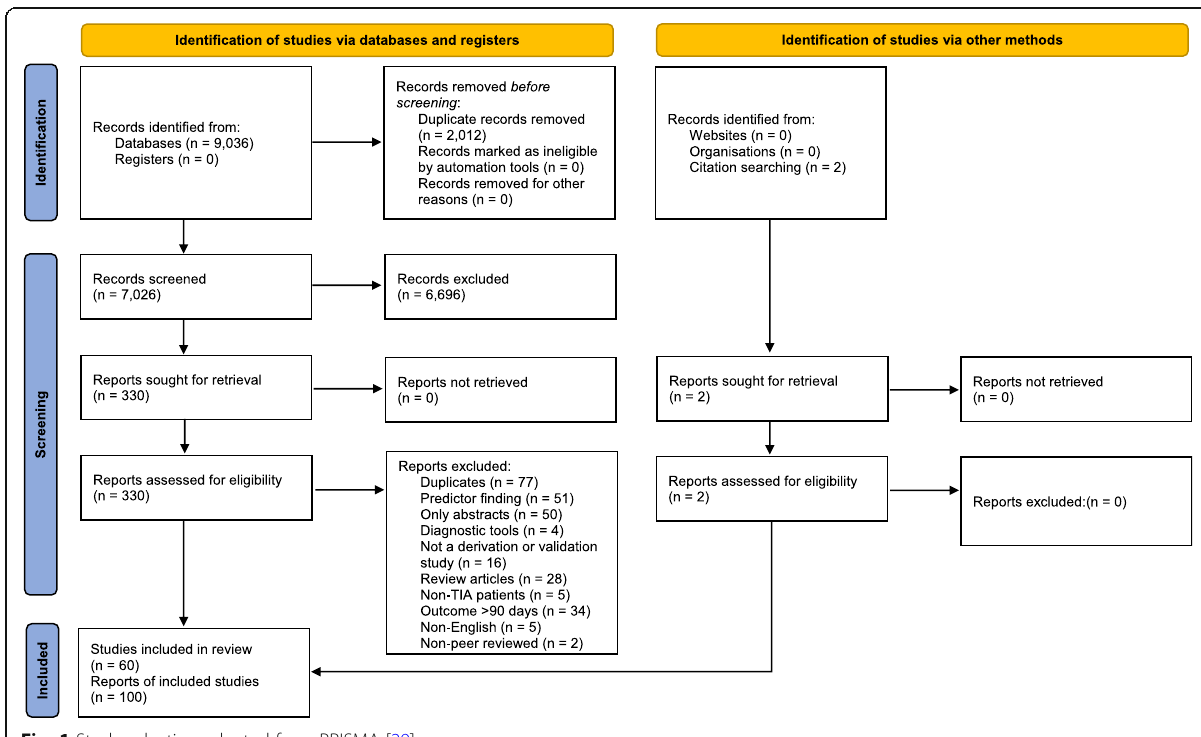
Fig. 1 Study selection adapted from PRISMA